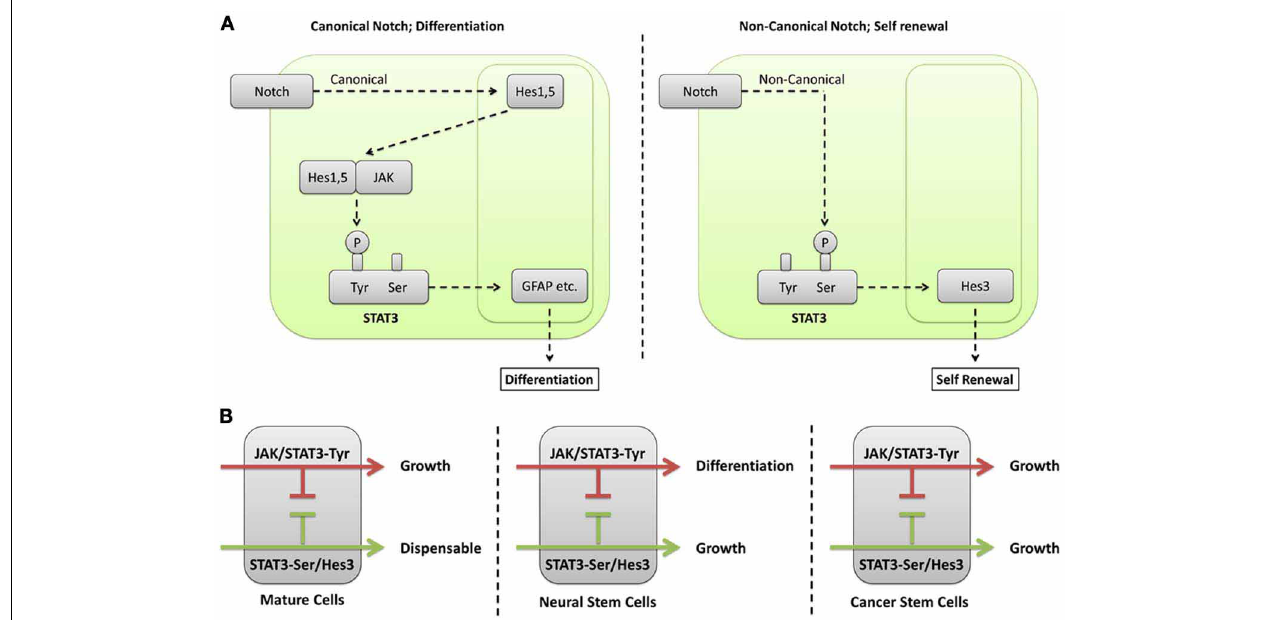
FIGURE 1 | (A) Different phosphorylation sites on STAT3 mediate canonical and non-canonical functions of the Notch signaling pathway. In canonical Notch signaling, the cleaved intracellular domain of the Notch receptor translocates to the nucleus where it regulates transcription of target genes, including Hes1 and Hes5. Hes1 and Hes5 are transcription factors themselves and can therefore regulate additional target genes downstream of Notch activation. However, they also have cytoplasmic functions where they form complexes with JAK2 promoting its ability to phosphorylate STAT3-Tyr (Kamakura et al., 2004). This modification leads to the induction of differentiation in NSCs (Bonni et al., 1997). A non-canonical branch of Notch signaling leads to STAT3-Ser phosphorylation in the absence of detectable STAT3-Tyr phosphorylation (Androutsellis-Theotokis et al., 2006). This is followed by increased transcription of Hes3. Hes3, in turn, promotes growth through poorly understood mechanisms. A clue as to the function of Hes3 comes from observations that force-expressed Hes3 in NSC cultures increases the expression of sonic hedgehog (Androutsellis-Theotokis et